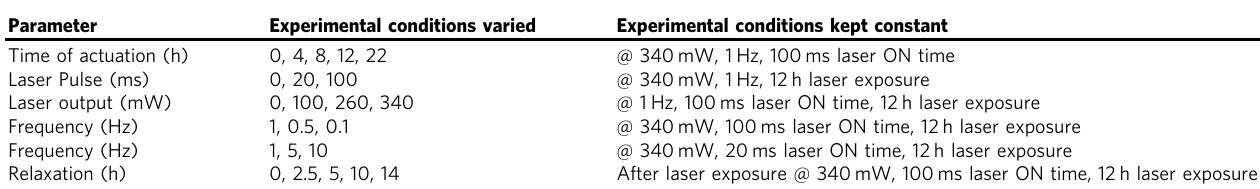
Table 1 Experimental parameters used for